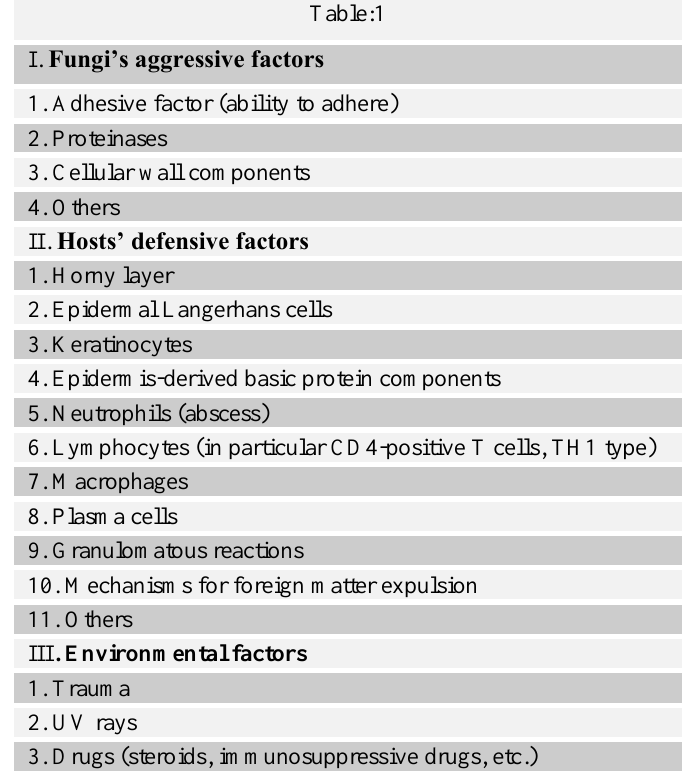
Table1. Mechanisms by which dermatomycosis occurs and factors involved in the defence of the body against fungi